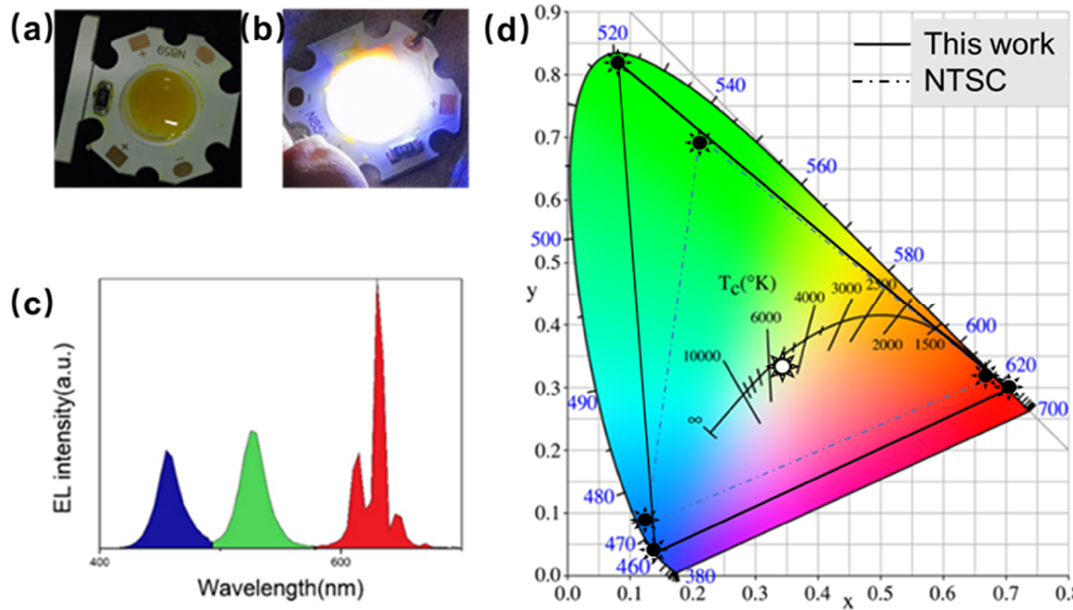
Figure 6. ( a ) Photograph of a WLED based on green CsPbBr 3 /Cs 4 PbBr 6 : Eu 3+ , red KSF phosphors, and a blue LED chip. ( b ) Photograph and ( c ) EL spectrum of the WLED driven at 20 mA. ( d ) The color coordinates of the WLEDs and the NTSC are shown in a CIE 1931 diagram.